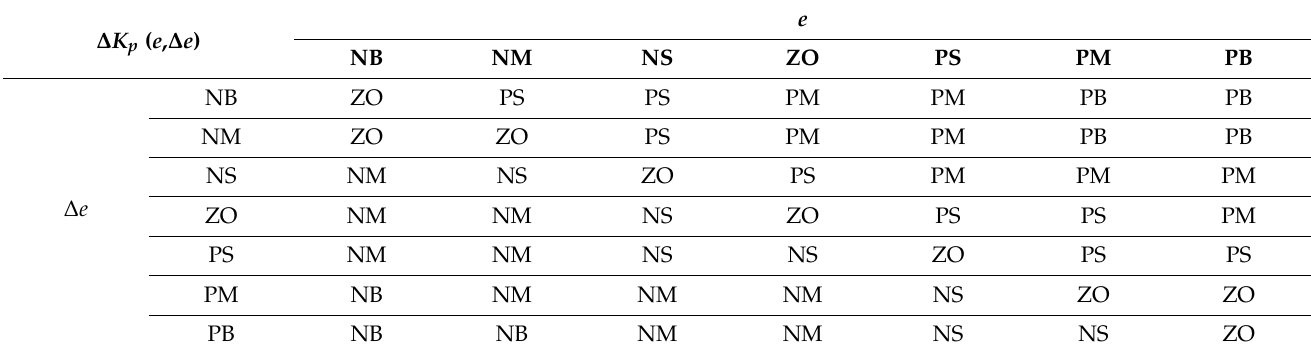
Table 2. Fuzzy rule base table for proportional gain ∆ K d .